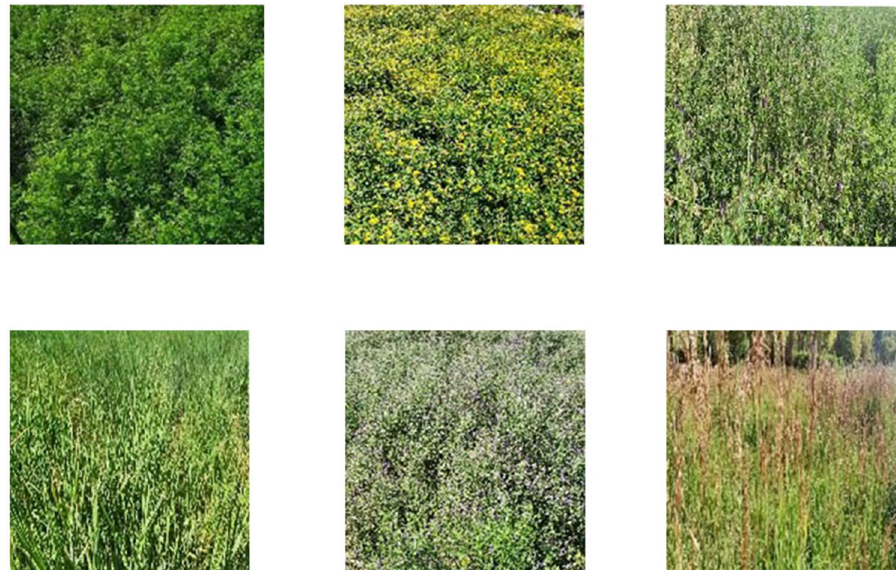
Figure 1. True color map of grass samples.